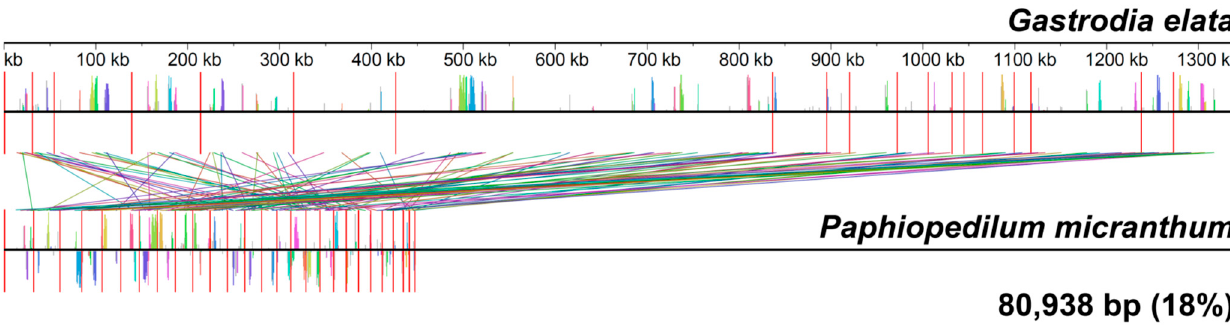
Figure 5. The colinear analysis of the mitogenome of Paphiopedilum micranthum and Gastrodia elata . Five of the six trans-splicing introns (nad1i394, nad1i669, nad2i542, nad5i1455, and nad5i1477) were shared with the common ancestors of seed plants [24]. The trans-splicing of nad1i728 (the fourth intron) was sporadically distributed among angiosperms [24,52], and most of the species sequenced in monocots presented trans-splicing of this intron,